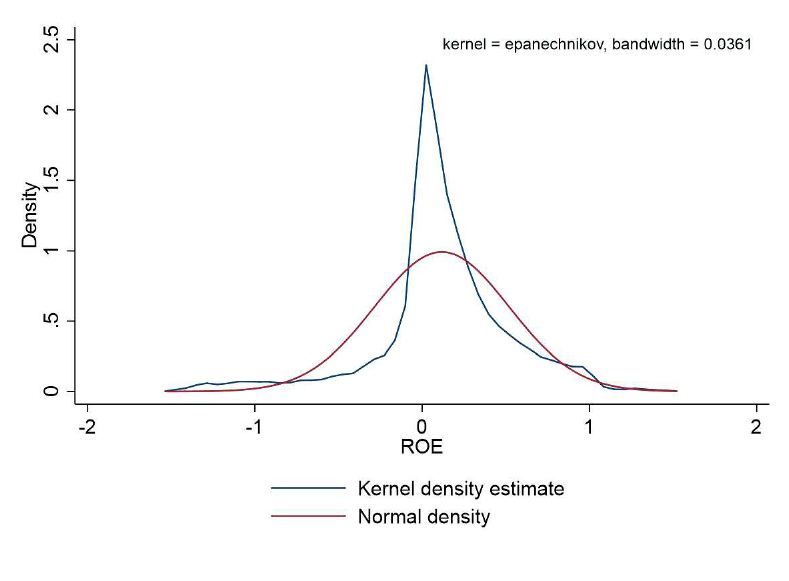
Figure 5. Kernel density estimate of Debt ratio (DR) Table 1. Descriptive statistics of ROE and DR